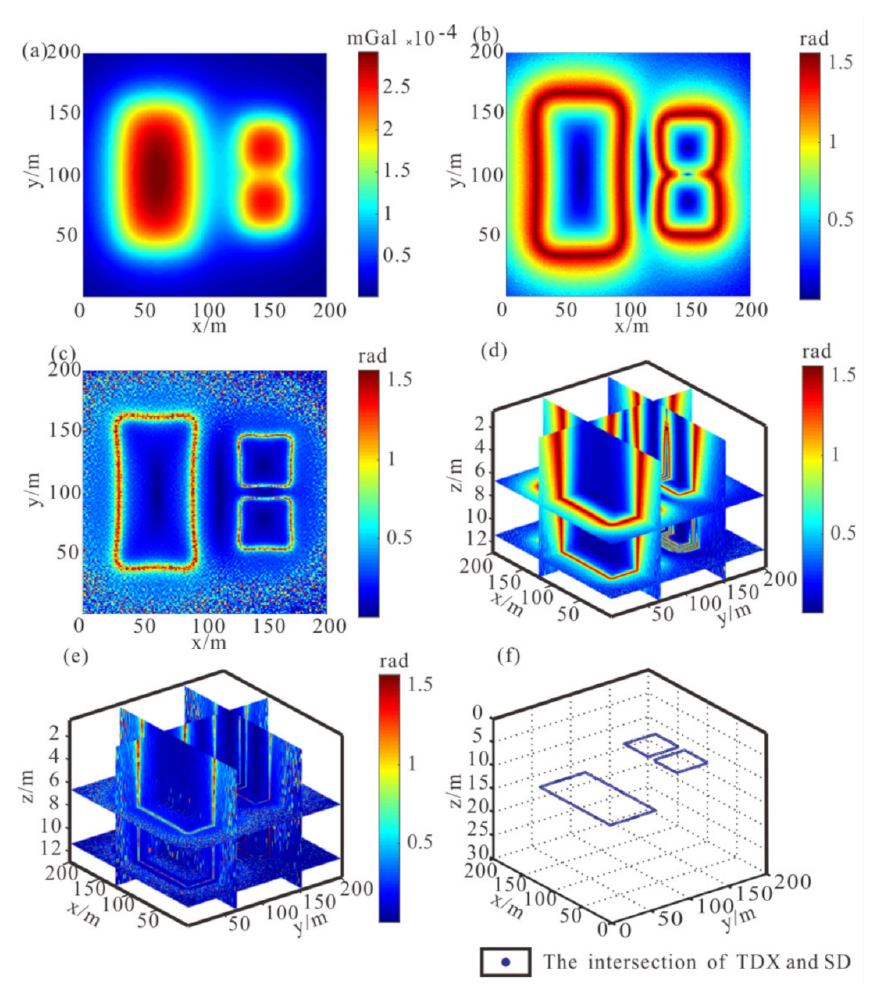
Figure 3. Imaging results of different-order vertical derivatives intersection of the noisy model: ( a ) Gravity anomaly of prisms model with SNR = 70 noise on the surface; ( b ) TDX result of gravity anomaly; ( c ) SD result of gravity anomaly; ( d ) TDX result of anomaly by downward continuation in the lower half space; ( e ) SD result of anomaly by downward continuation in the lower half space; ( f ) Imaging results of